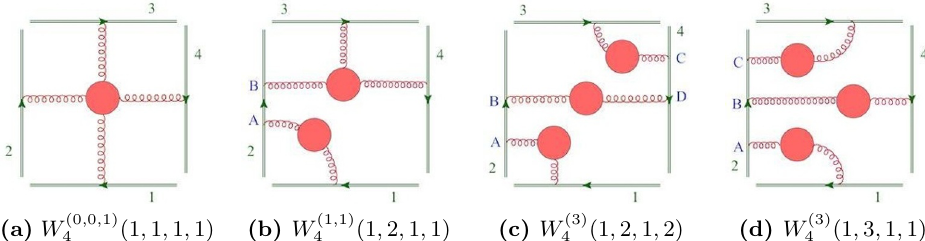
Figure 8. Representative skeleton diagrams for the four non-vanishing Cwebs in a massless theory connecting four Wilson lines, and whose perturbative expansion starts at O ( g 6 ). Their respective numbers of skeleton diagrams are f 1 ; 2 ; 4 ; 6 g